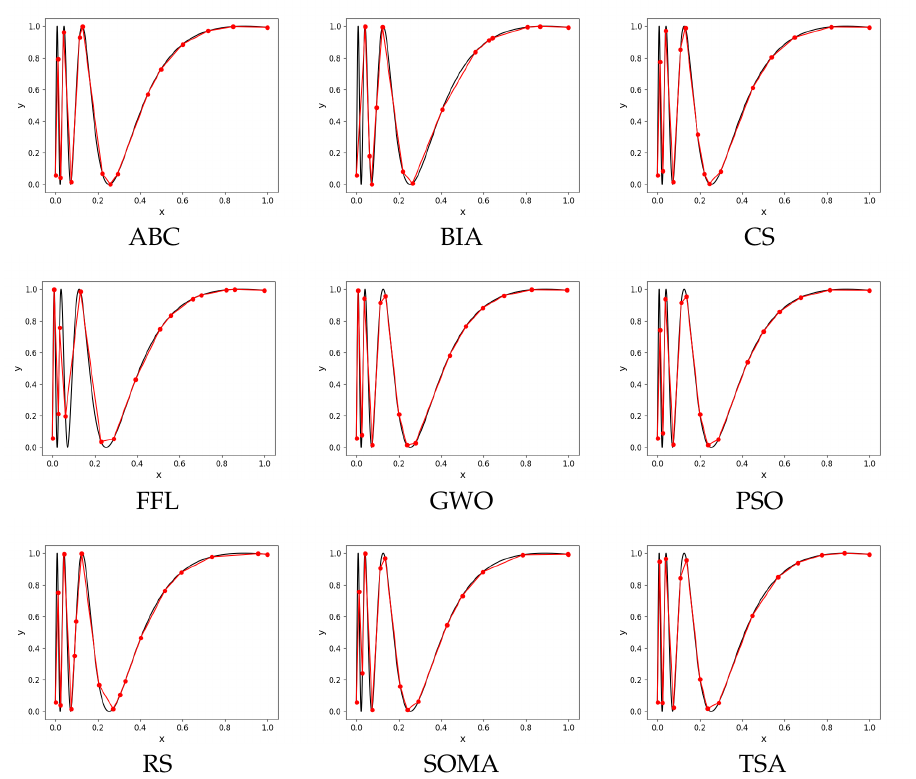
Figure 2. Each graph represents the best result of a specific algorithm. The total number of points was set to 16 and maxFES =